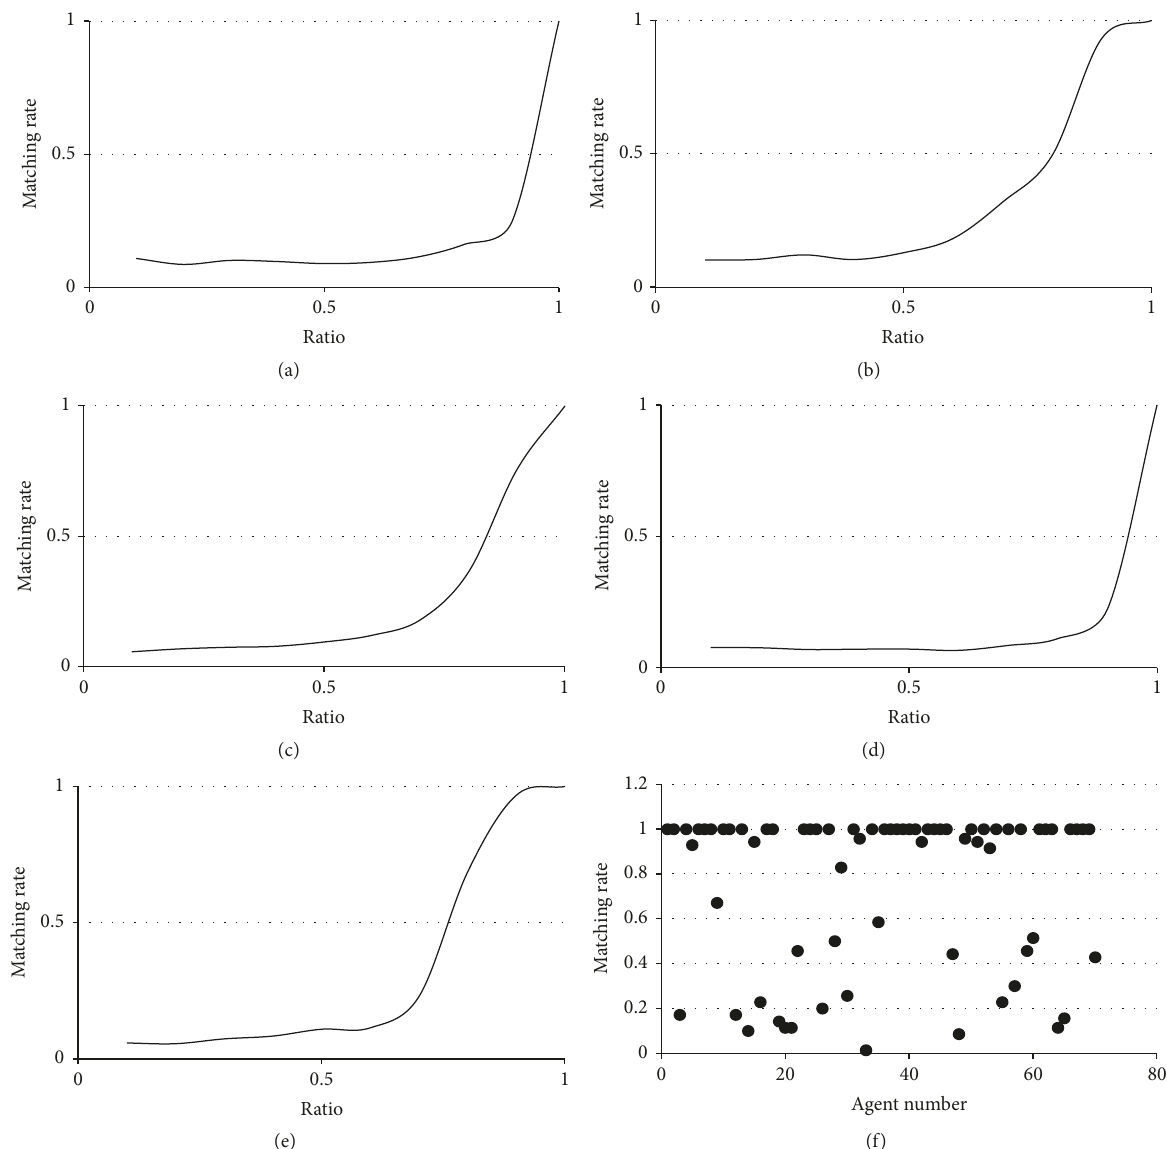
Figure 1: Matching rate of successive two trials regarding ratio (symmetric TSP). (a) Data from eil51. (b) Data from berlin52. (c) Data from st70. (d) Data from eil76. (e) Data from pr76. (f) An example of matching rate distributions for each agent (data from st70 are shown). The smaller the ratio is, the more frequently the agent chooses the furthest site. Matching rate becomes worse at that situation.